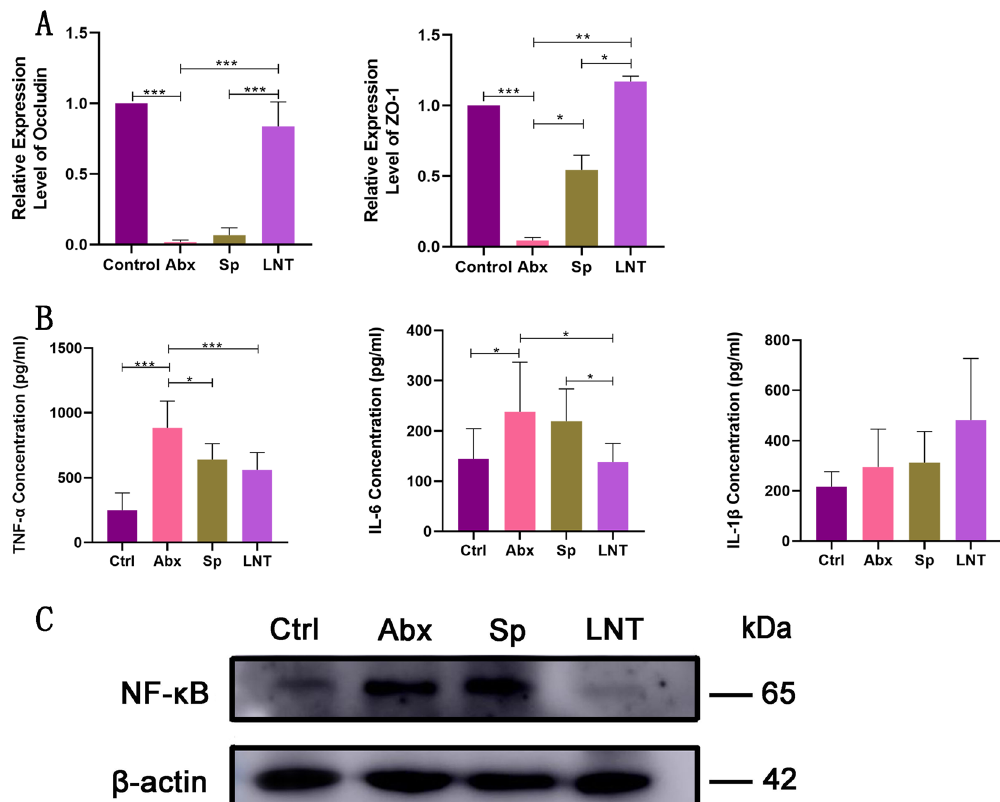
Figure 4. ( A ) The relative expression of intestinal tight junction (ZO-1 and Occludin) in the colon. ( B ) The levels of inflammatory cytokines (TNF-α, IL-6 and IL-1β) in the colon. ( C ) Expression of NF-κB in different groups using β-actin as an internal control. Western blots are representative of three independent experiments. Different groups by one-way ANOVA procedure followed by Duncan test. * p < 0.05, ** p < 0.01, *** p < 0.001. All error bars are